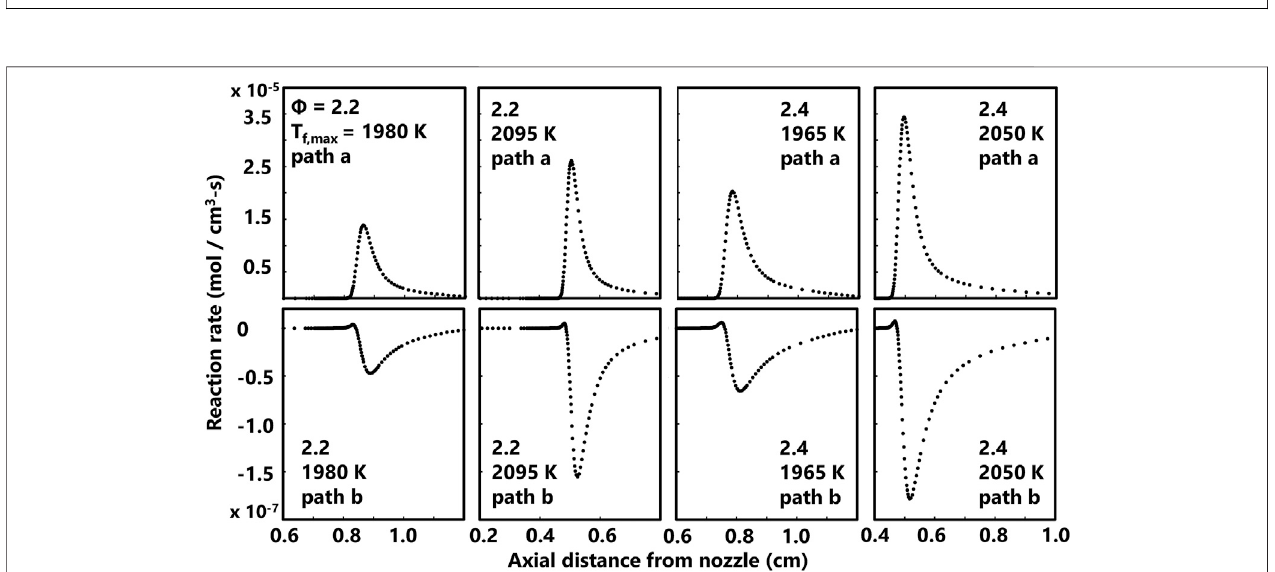
FIGURE 8 | Computed rates of two common benzene (A1) production reactions for four fl ames spanning the range of equivalence ratios and fl ame temperatures currently studied. The top row is the axial pro fi le for the net rate of 2C 3 H 3 (cid:129) H (path